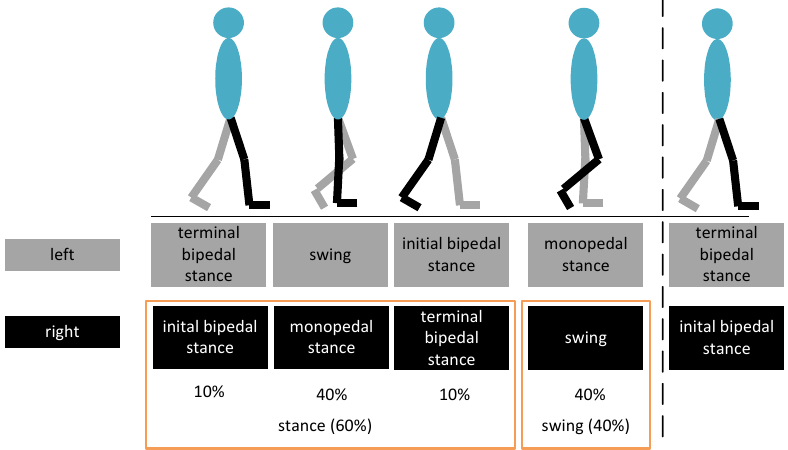
Figure 1. Monopedal (single support) and bipedal (double support) phases of gait over one gait cycle (based on [22]), with corresponding average percentages of gait cycle. Each initial bipedal stance phase begins with initial contact (IC), followed by loading response (LR). Monopedal stance covers mid-stance (MS), and terminal bipedal stance begins with terminal stance (TS) and ends with toe-off (TO), directly leading to the swing phase.